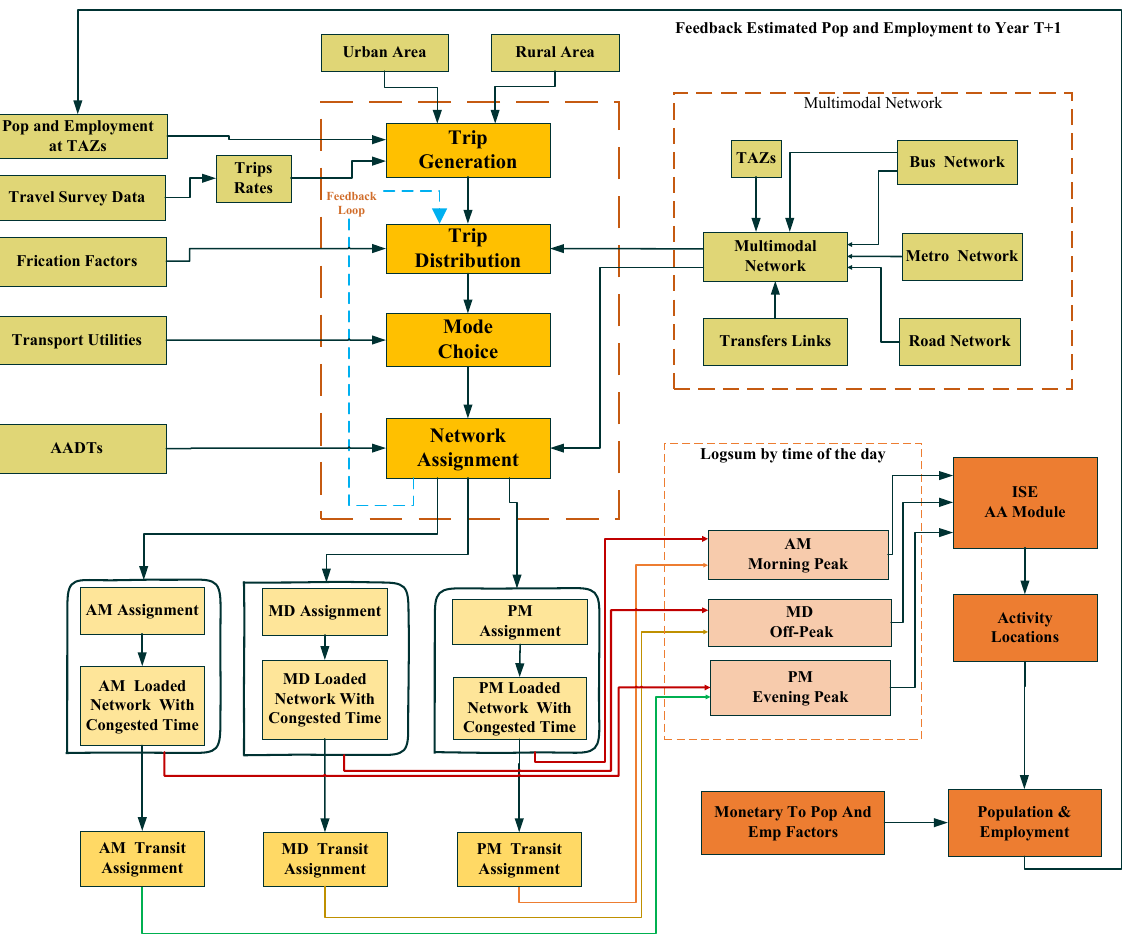
Figure 4. Workflow of time-dependent transport model.